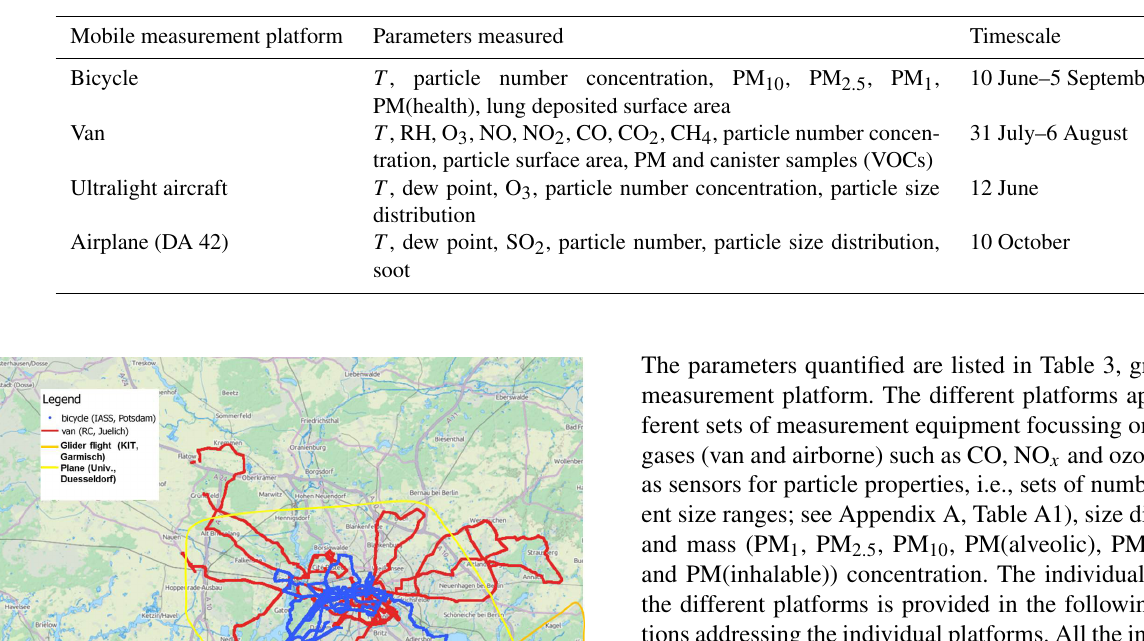
Table 3. List of applied mobile measurement platforms, parameters quantified and timescales.